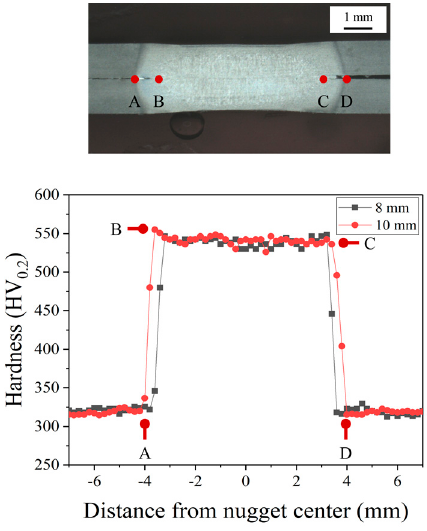
Figure 3. Fracture shape after tensile test: electrode face diameter of ( a ) 8 mm, ( b ) 10 mm.